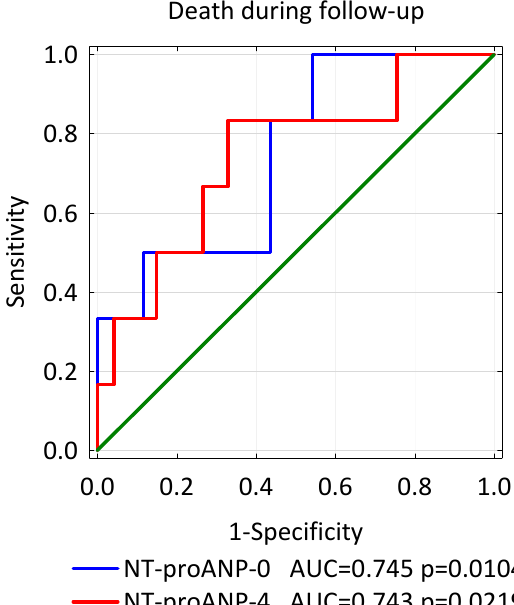
Figure 3. ROC curves-variables tested: the concentration of NT-proANP on admission to the hospital (NT-proANP-0) and on the 4th day of hospitalization (NT-proANP-4) in identifying patients at risk of death during follow-up.